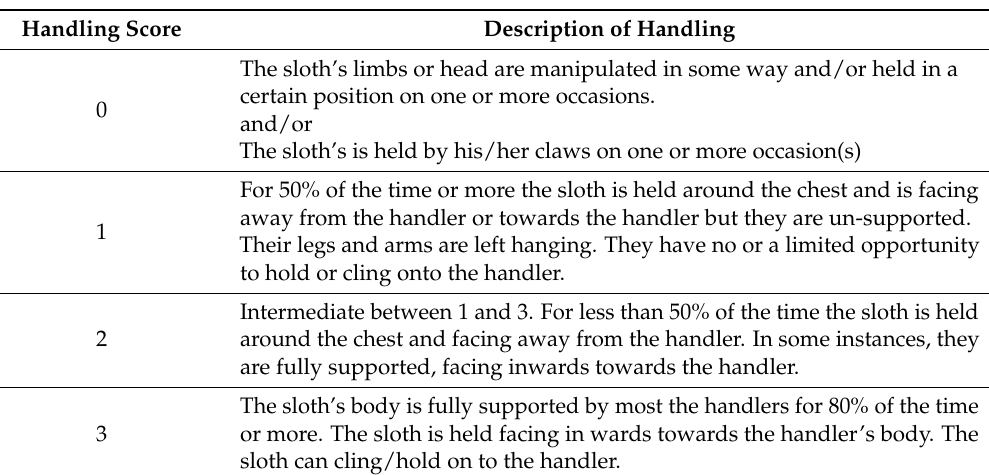
Table 3. Handling scores and